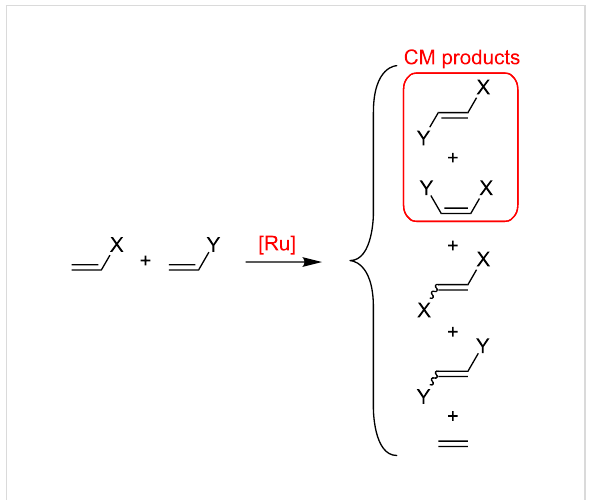
Scheme 1: Possible products resulting from the CM of terminal